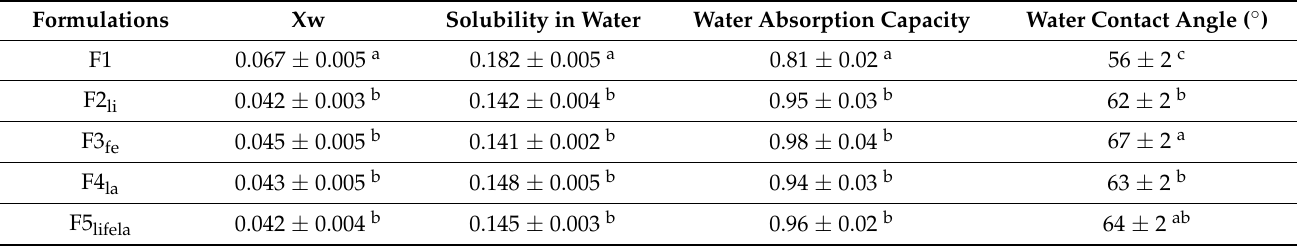
Table 3. Mean values and standard deviation of moisture content (Xw, (g water/g dried film)), solubility in water (g solubilized film/g initial dried film), water absorption capacity (g water/ g dried film), and contact angle with water ( ◦ ) of the different films after one week of storage at 53% relative humidity and 25 ◦